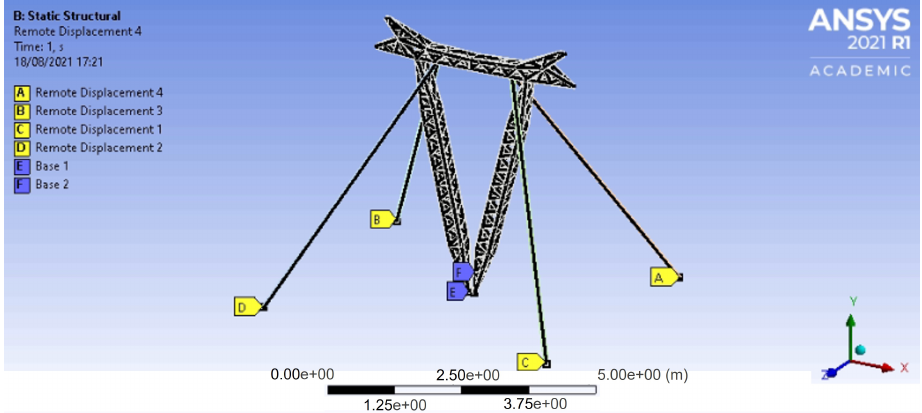
Figure 19. Finite element model of the mockup tower assembled in LabEDin